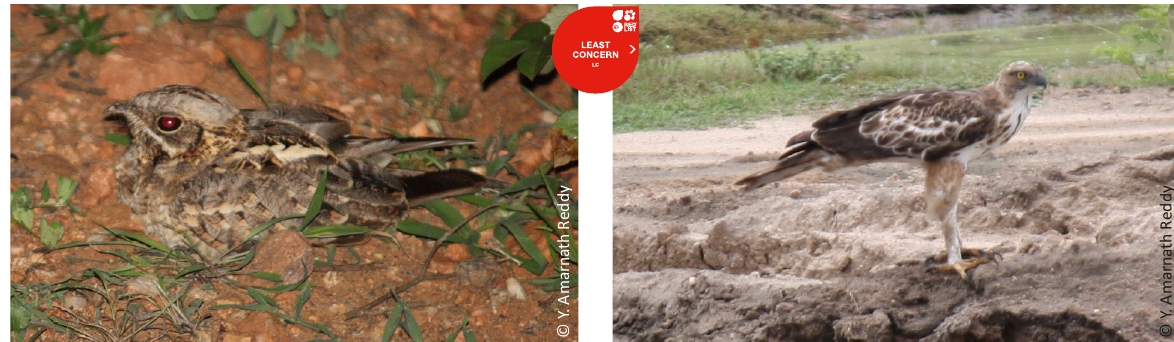
Image 3. Ardeola grayii Indian Pond-heron